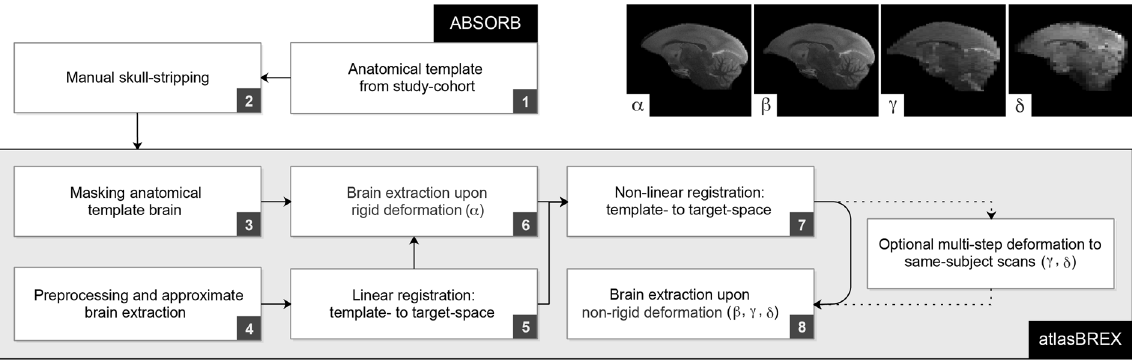
Figure 2. Workflow of atlasBREX for (semi-) automated brain extraction. In a first step (1), an unbiased anatomical template is constructed from the respective study-cohort using ABSORB, which is then subject to manual (hybrid) skull-stripping (2). Upon preprocessing in order to optimize the following image registration and initial approximate brain extraction (3), rigid and non-rigid deformation (5 and 7) fields are computed from template- to target-space, which are applied to the template mask in order to compute a subject-specific brain mask (6 and 8). Optional multi-step deformation to other target volumes, such as structural low- resolution ( γ ) and functional scans ( δ ), can be performed. Panels on the top-right demonstrate results from an adult marmoset upon rigid ( α ) and non-rigid ( β ) deformation as well as the results from the corresponding structural low-resolution ( γ ) and functional scans ( δ ).